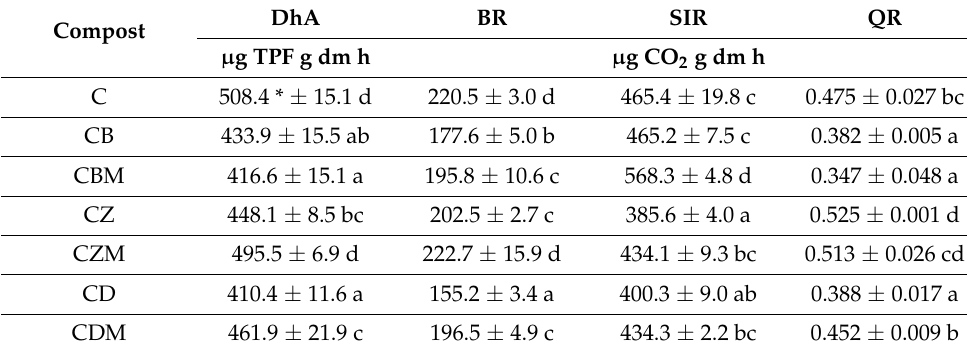
Table 4. Biochemical indicators of composts (mean ±